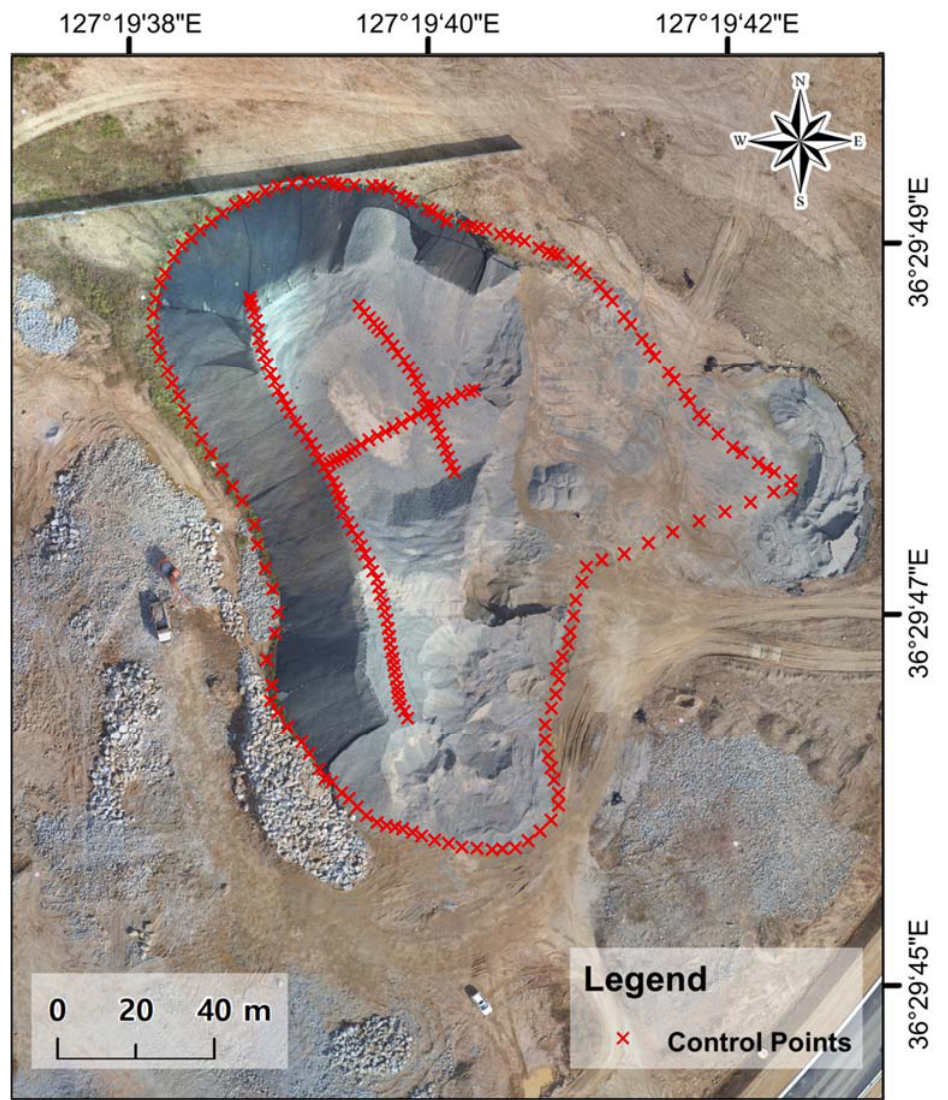
Figure 4. Control point (CP) positions in the study area.